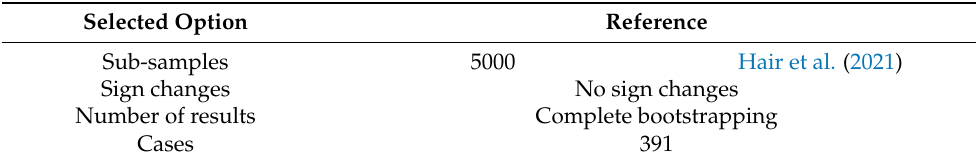
Table 3. Heterotrait – monotrait ratio (HTMT) matrix.